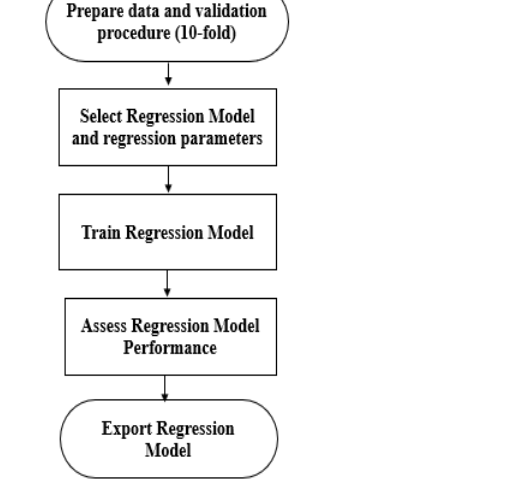
Figure 5. General workflow for the regression procedure.